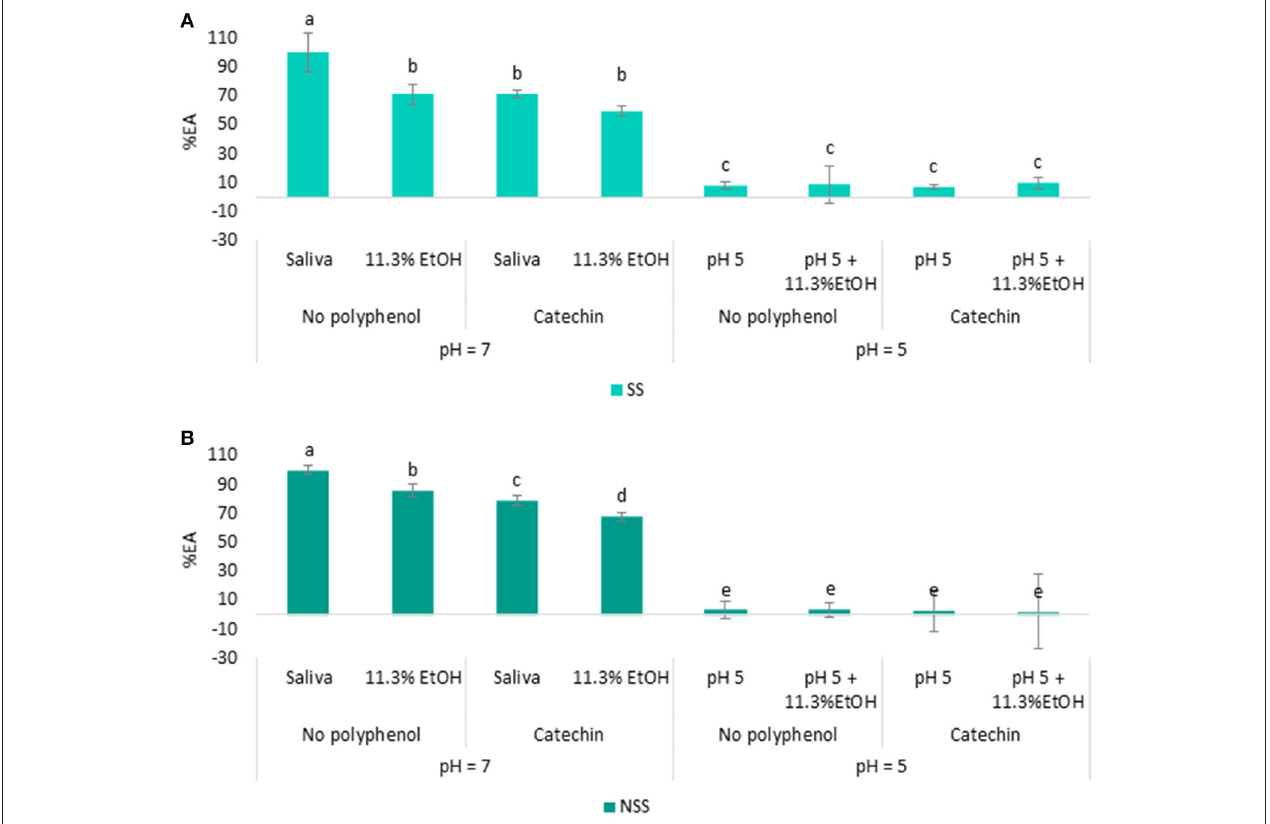
FIGURE 5 | Percentage of EA determined in SS (A) and NSS (B) using wine consumption conditions: 11.3% ethanol, pH = 5 and with or without